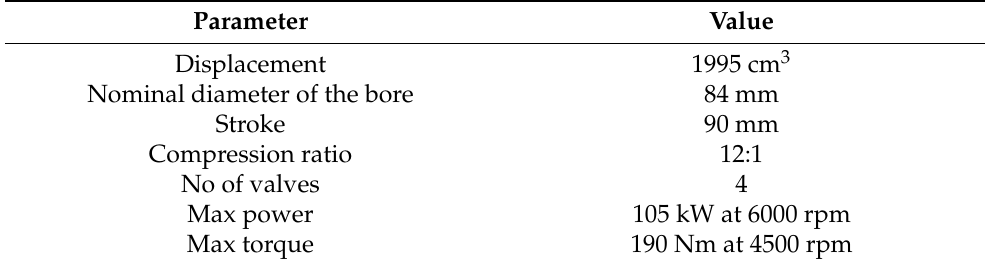
Table 1. Engine specification.